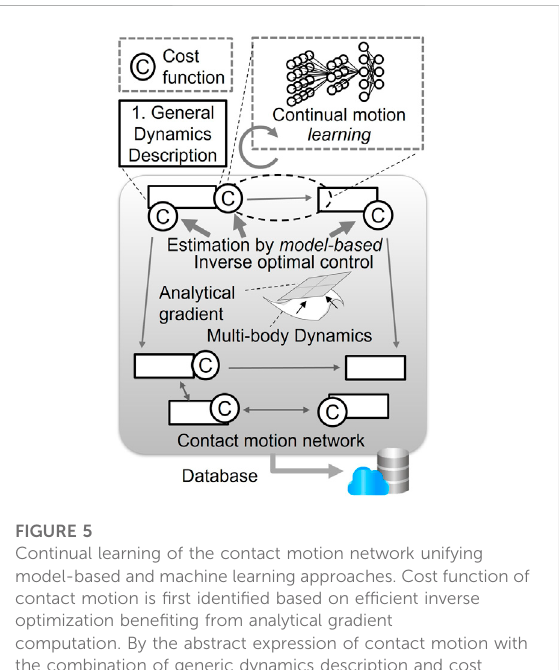
FIGURE 4 Generic descriptor of anthropomorphic contact motions, including body and environment models, motion parameters, contactconstraints,andtheirsequences.Thiscompactexpression allows the standard expression for the upcoming